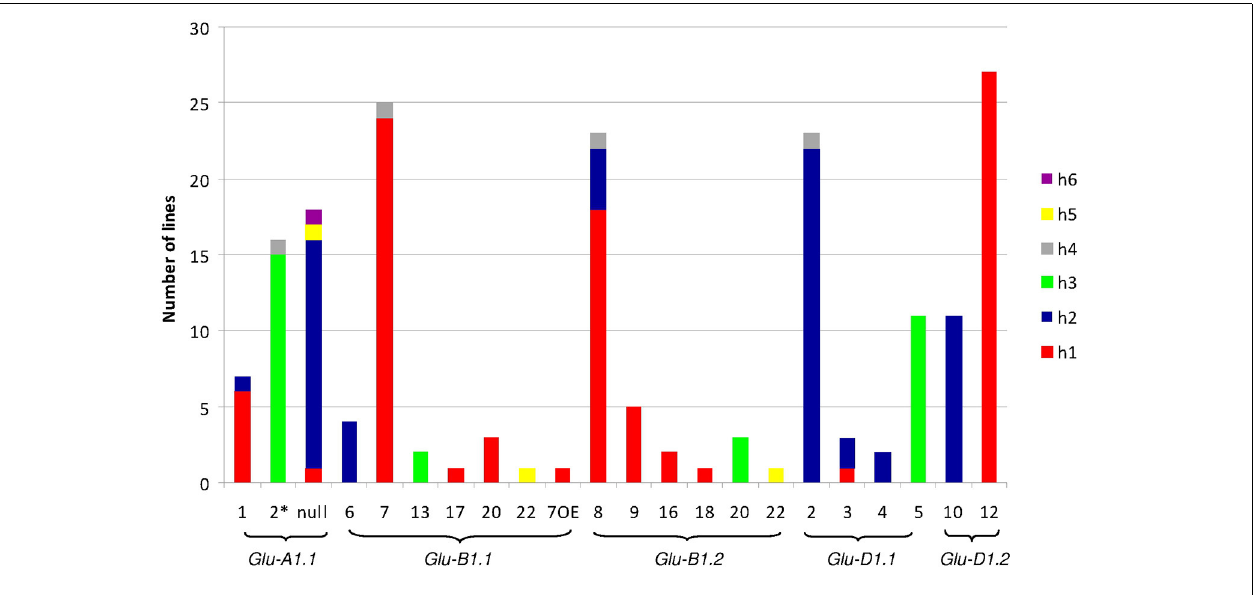
FIGURE 1 | Number of lines of each haplotype of HMW-GS gene promoter for all electrophoretic forms of HMW-GS present in the set of 42 lines studied. The promoter haplotypes are named h1 to h6. The same